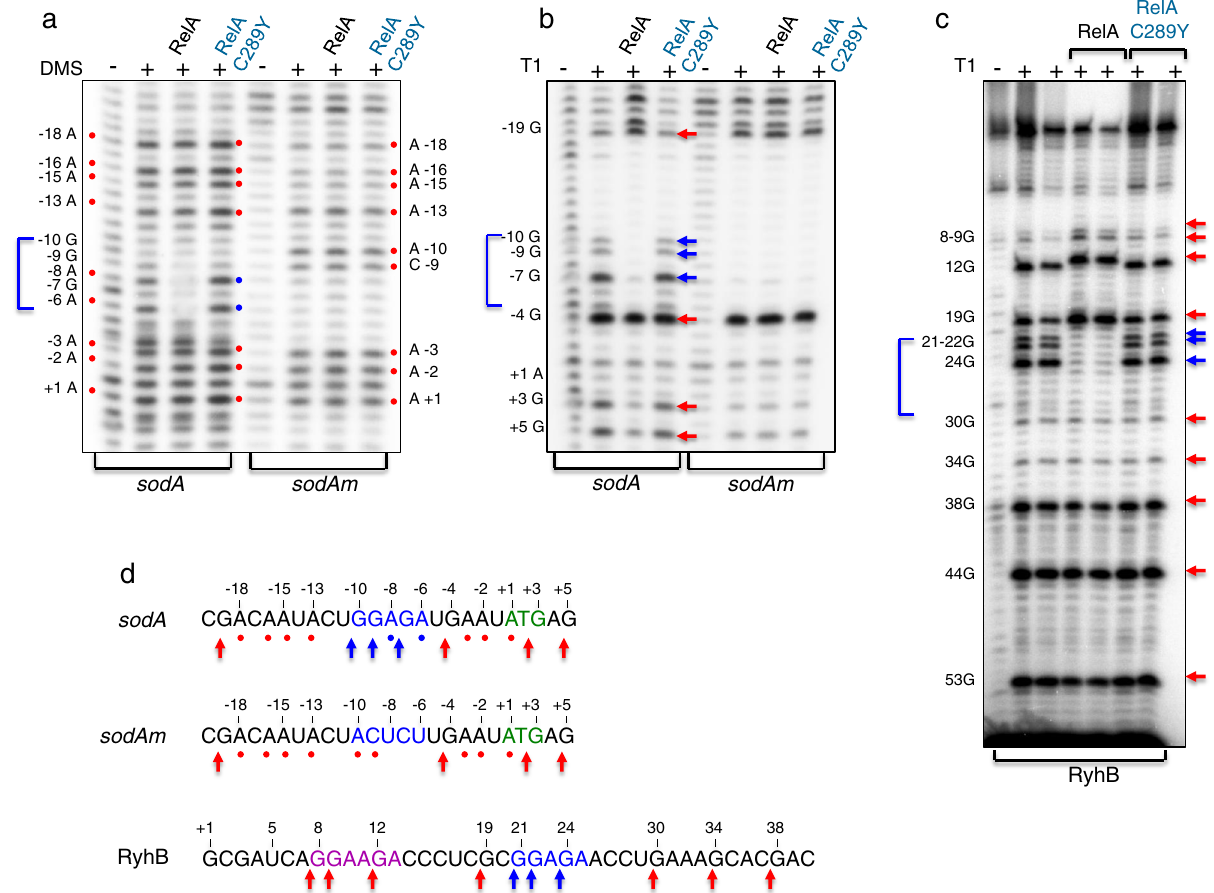
Fig. 3 RelA interacts with RNA through a speci fi c sequence. a Footprinting of RelA using DMS modi fi cation. Wild type (black) and mutant (blue) RelA proteins (5 pmol) incubated with (0.5 pmol) RNAs (RyhB 90 nt; sodA 98 nt) were exposed to DMS modi fi cation (0.3%) for 5 min at 25 °C. sodA carries an intact GGAGA sequence while sodA m carries ACUCU. Reverse transcription of untreated ( − ) and DMS treated ( + ) RNA samples. The red circles indicate the positions methylated by DMS. The numbers on the right and left indicate the sequence position relative to the nucleotide A of the start codon of sodA ( + 1). Wild type RelA protects residues A-8 and A-6 from methylation (blue circles). Nucleotides A-10 and C-9 in sodA m RNA are methylated (red circles) in the presence of either wild type or RelA:C289Y mutant. b , c Footprinting of RelA using RNase T1. RNAs and proteins incubated as in a were treated by RNase T1 (0.1 U) for 5 min at 37 °C ( b ) or with 0.2 U and 0.4 U ( c ). Reverse transcription of untreated ( − ) and RNase T1 treated ( + ) RNA samples. The numbers on the left indicate the sequence position relative to the nucleotide A of the start codon of sodA ( b ) and the transcription start site + 1 of RyhB ( c ). The red arrows indicate the positions of the G residues cleaved by RNase T1, while the blue arrows represent the regions of protection. d RelA protects GGAGA sequence of RyhB and sodA . The sequences GGAGA (blue), AUG (green), and variant GGAAGA (purple) are denoted. In sodA m GGAGA was changed to ACUCU. Red circles and arrows indicate strong modi fi cation and cleavage sites. Blue circles and arrows indicate the region protected by RelA. The products were analyzed in 6% acrylamide 8 M urea-sequencing gel. Source data with MW labeled marker (pUC18) and sequencing reactions is provided as a source data fi